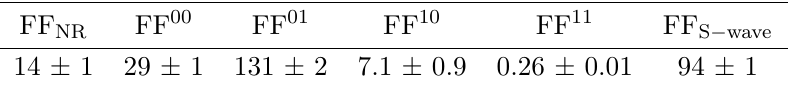
Table 4 . Relative fractions (%) of the various components of the Triple-M amplitude. The uncer- tainties correspond to the combined statistical and systematic